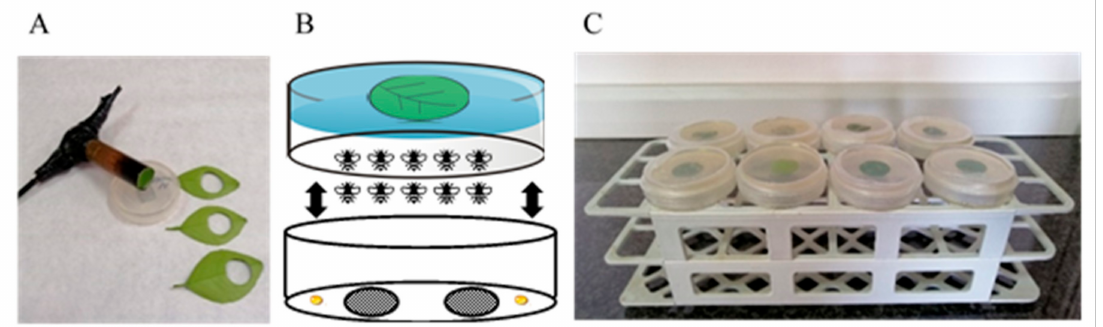
Figure 1. ( A ) Leaf discs cut through a cork borer. ( B ) Overview of assembly of each. Petri dish. ( C ) Inverted Petri dishes in a laboratory